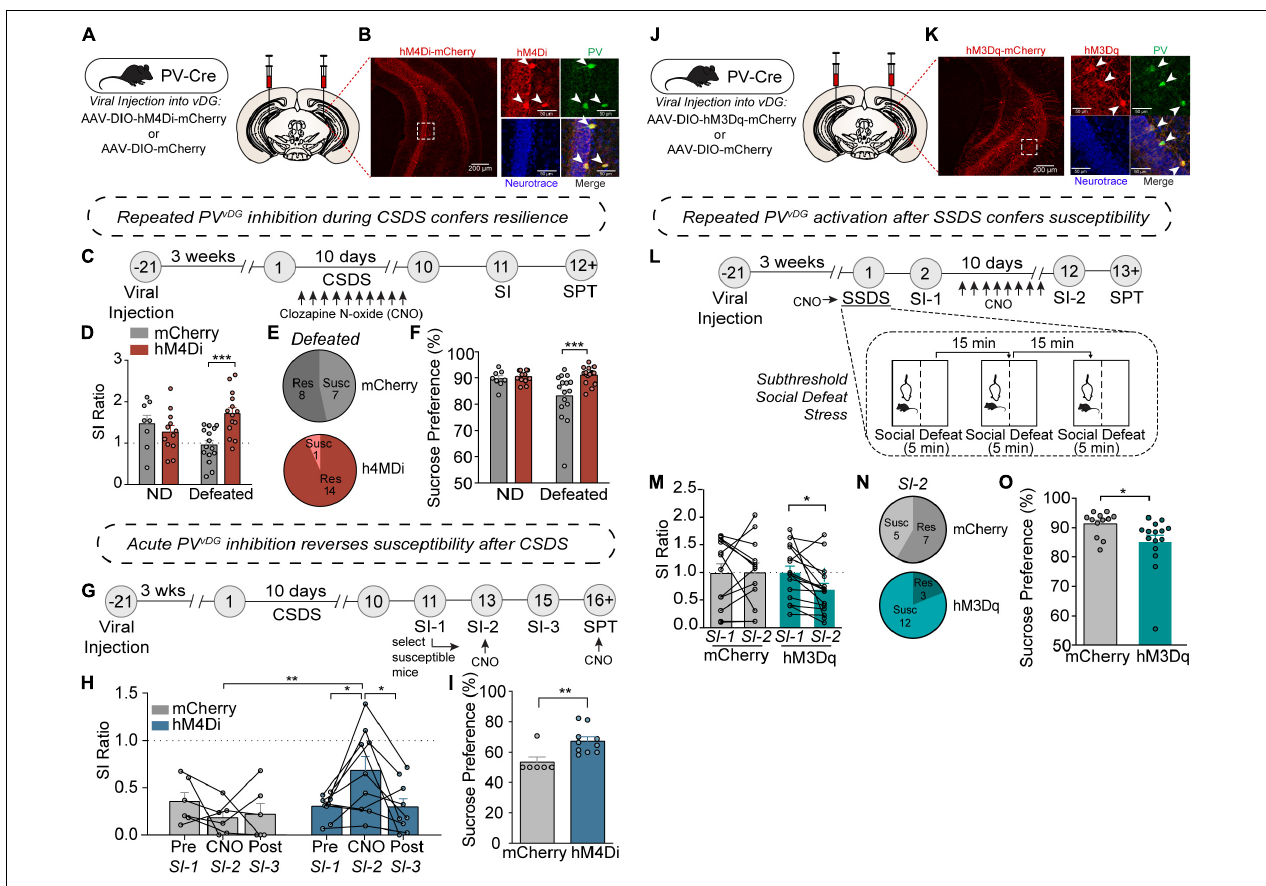
FIGURE 2 | PV neuron activity in the vDG mediates resilience or susceptibility to CSDS. (A) Viral injection strategy for expression of hM4Di-mCherry or mCherry in vDG of PV-Cre mice. (B) Representative images showing hM4Di-mCherry expression in the vDG (left image; scale bar, 200 µ m) and high magnification images of a dotted rectangular region showing selective expression of hM4Di-mCherry in PV neurons (right images; scale bar, 50 µ m). (C) Timeline of repeated CNO treatments during CSDS and behavioral experiments. (D) Repeated CNO-treatment resulted in increased SI ratio [two-way ANOVA, Non-defeat (ND): mCherry ( n = 8) and hM4Di ( n = 12), Defeated: mCherry ( n = 15) and hM4Di ( n = 14)]. (E) Pie charts showing the number of resilient and susceptible animals after repeated injections of CNO during CSDS. (F) Chronic-CNO treatment during CSDS resulted in hM4Di mice displaying increased sucrose compared to mCherry controls [two-way ANOVA, Non-defeat: mCherry ( n = 8) and hM4Di ( n = 12), Defeated: mCherry ( n = 16) and hM4Di ( n = 16)]. (G) Timeline of CSDS, acute CNO treatments and behavioral experiments. (H) Acute CNO-treatment resulted in increased SI ratio only in hM4Di but not in mCherry control group during SI-2 test [two-way repeated measures ANOVA, mCherry ( n = 6) and hM4Di ( n = 9)]. (I) After acute-CNO treatment, hM4Di group displayed increased sucrose preference in SPT compared to mCherry control group [unpaired two-tailed t -test, mCherry ( n = 6) and hM4Di ( n = 10)]. (J) Viral injection strategy for expression of hM3Dq-mCherry or mCherry in vDG of PV-Cre mice. (K) Representative images showing hM3Dq-mCherry expression in the vDG (left image; scale bar, 200 µ m) and high magnification images of a dotted rectangular region showing selective expression of hM3Dq-mCherry in PV neurons (right images; scale bar, 50 µ m). (L) Timeline of SSDS, CNO treatments and behavioral experiments, and diagram of SSDS. (M) Comparison of SI ratio obtained from SI-1 (tested after an acute injection of CNO immediately followed by SSDS) versus SI-2 (tested after repeated daily injections of CNO for 10 days). After chronic injections of CNO, hM3Dq mice displayed increased social avoidance compared to mCherry controls [two-way repeated measures ANOVA, mCherry ( n = 12) and hM3Dq ( n = 15)]. (N) Pie charts showing the number of resilient and susceptible animals resulting from repeated injections of CNO after SSDS. (O) After repeated injections of CNO, hM3Dq mice displayed decreased sucrose preference compared to mCherry controls in SPT [unpaired two-tailed t -test, mCherry ( n = 12) and hM3Dq ( n = 15)]. Data are expressed as mean ± SEM, and individual data points are depicted. Post hoc Bonferroni’s multiple comparisons were used for ANOVA. * p < 0.05, ** p < 0.01, *** p < 0.001.